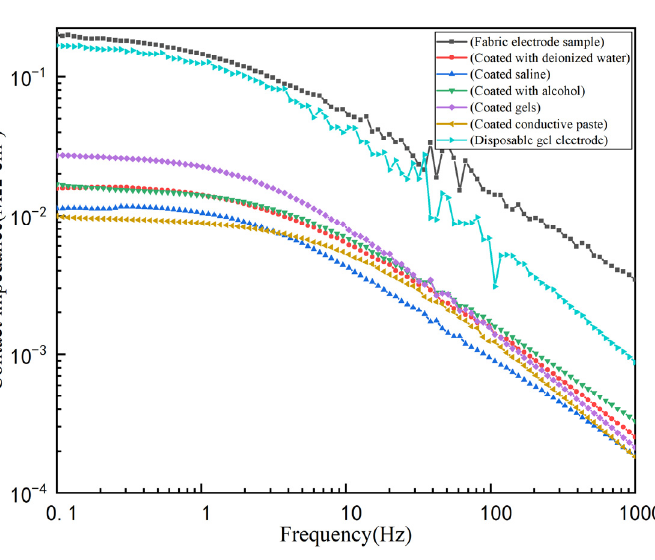
Figure 5. The contact impedance between the electrode surface of the cotton fabric and the skin after coating with different media reagents.